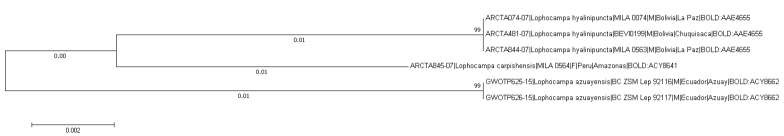
Neighbor-Joining Tree for the six specimens of the Lophocampahyalinipuncta group. Boot-strap values (in %, 1000 replicates) are given on each branch (obtained with MEGA5, see Tamura et al. 2007).